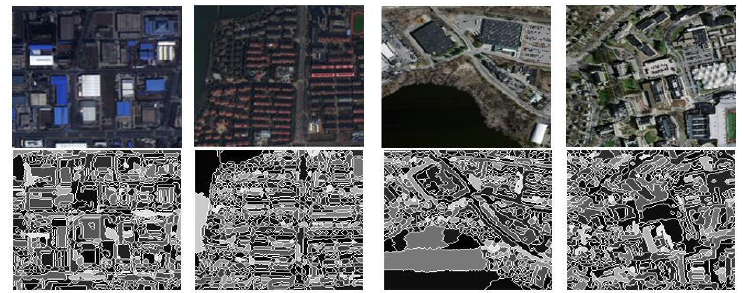
Figure 7. Remote sensing image after edge segmentation.